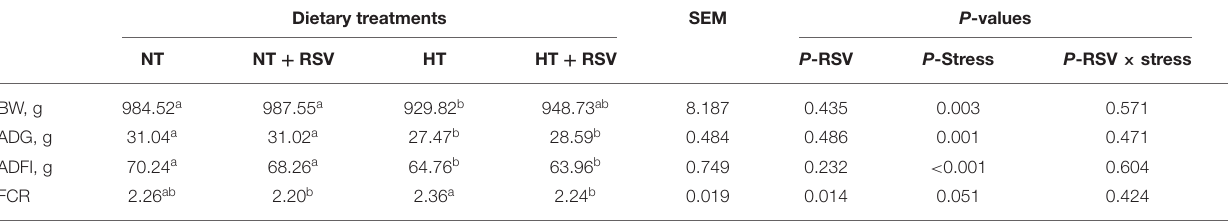
TABLE 3 | Effect of heat stress and RSV on growth performance of 42-day-old broilers (14 of heat treatment). Dietary treatments SEM P -values NT + RSV P -RSV P -Stress